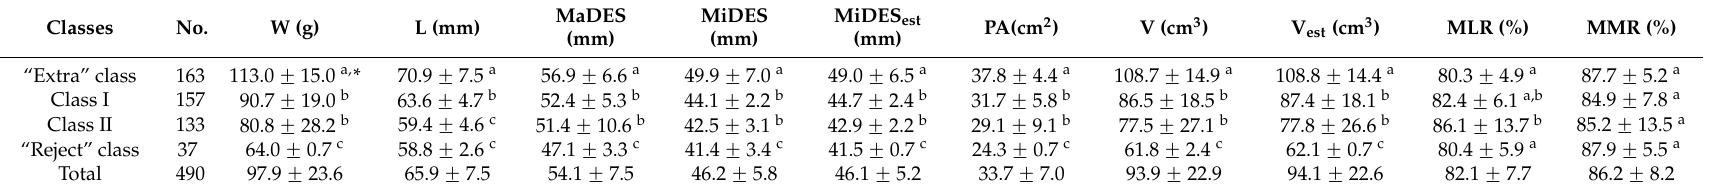
Table 1. Typical physical properties and estimated parameters (Mean ˘ standard deviation) of all kiwifruit samples in different